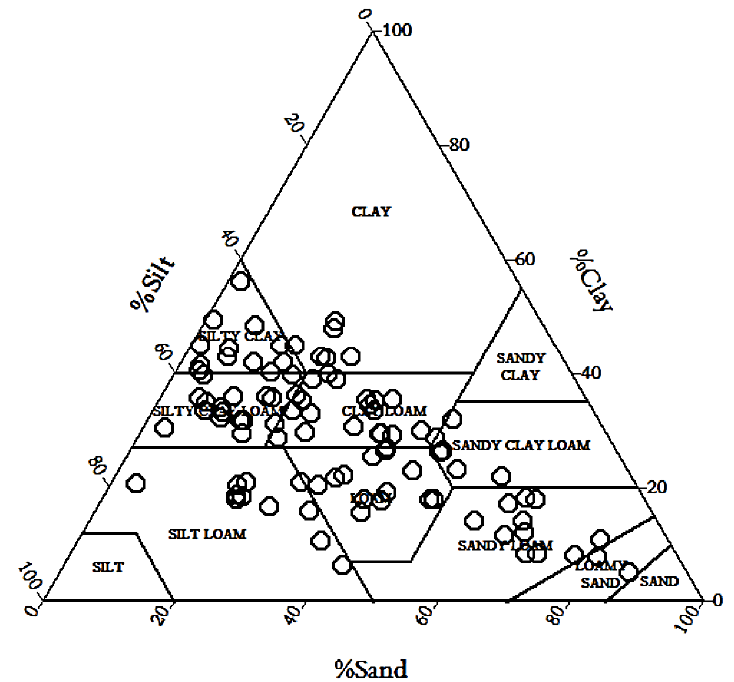
Figure 2. Maps of the ( a ) elevation, ( b ) slope, and ( c ) aspect of the study area.